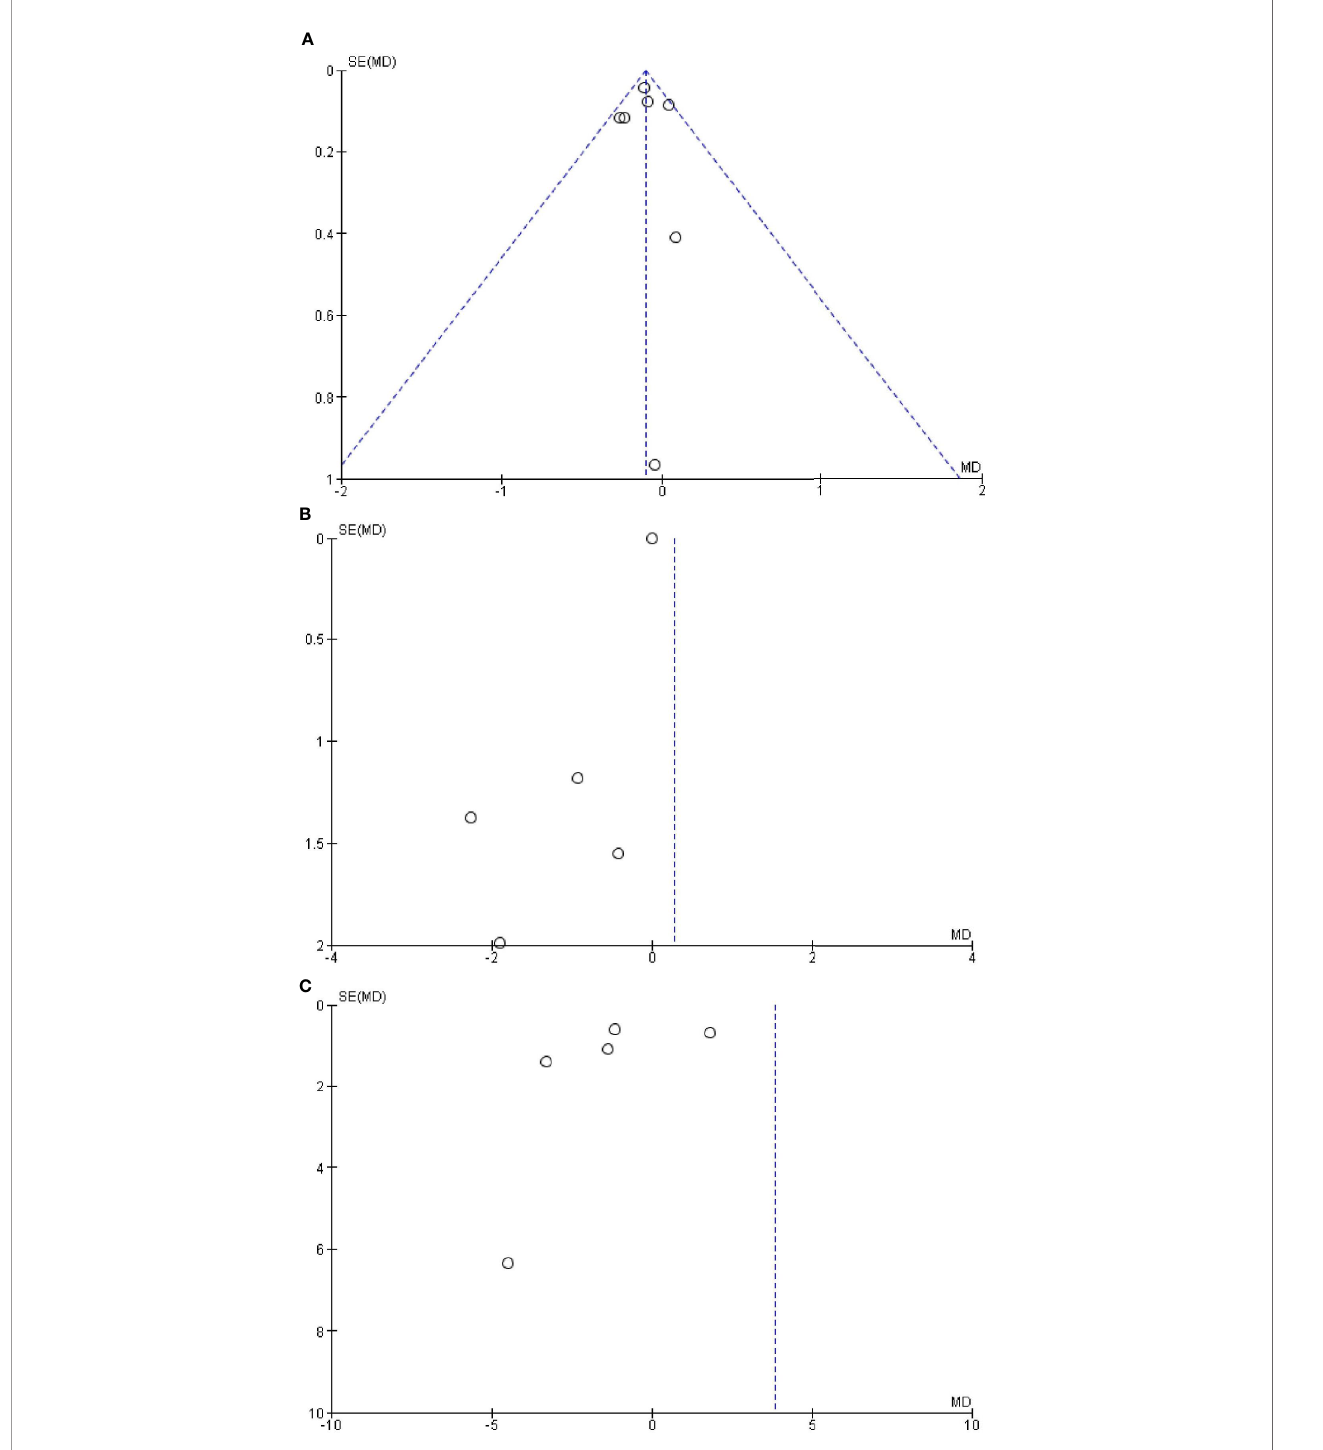
FIGURE 5 | Funnel plot of the (A) salivary, (B) serum, and (C) plasma levels of cortisol in adult obstructive sleep apnea syndrome versus the control group. Black circles represent imputed studies. Open circles represent observed studies. SE, Standard error; MD, Mean